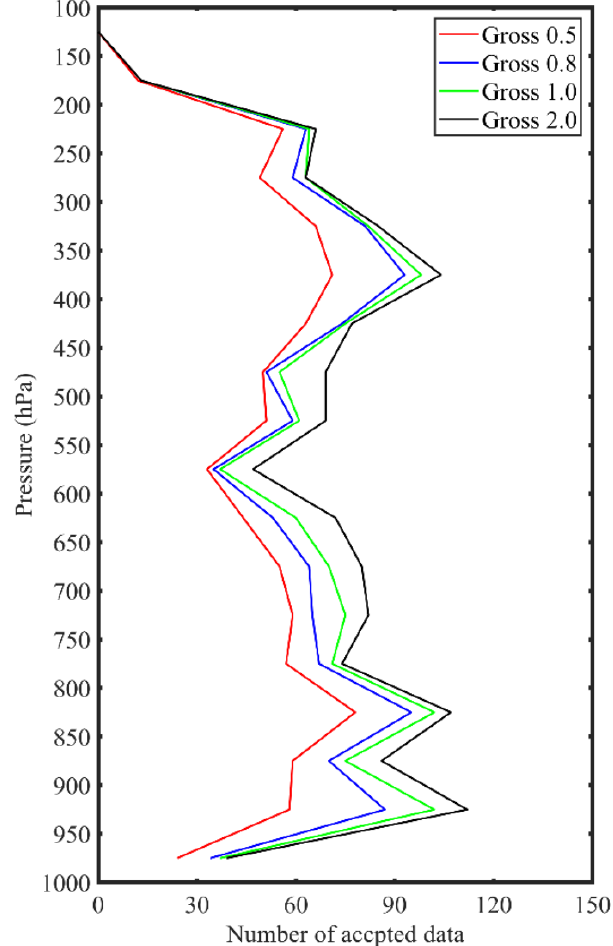
Figure 12. Number of accepted TDR data at different heights with different gross errors at 18 UTC 2 August 2016.